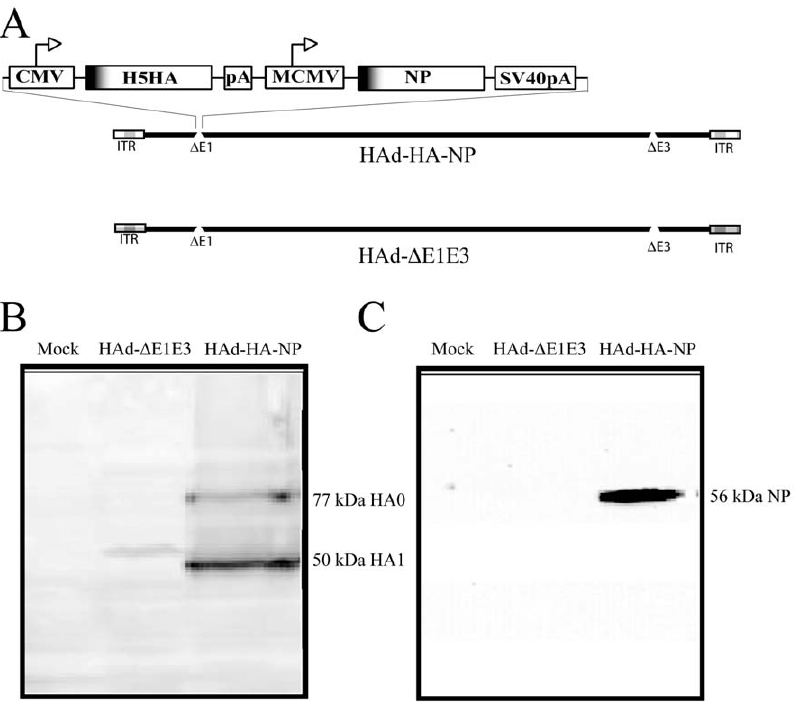
Figure 1. Replication-defective HAd vector (HAd-HA-NP) expresses HA and NP of a H5N1 influenza virus in vector-infected cells. (A) Diagrammatic representation of replication-deficient HAd vectors, HAd- D E1E3 [HAd5 with deleted E1 and E3 regions] and HAd-HA-NP [HAd- D E1E3 with hemaggluttinin (HA) and nucleoprotein (NP) gene from A/Vietnam/1203/04 (H5N1) influenza virus]. ITR, inverted terminal repeat; CMV, cytomegalovirus immediate early promoter; pA, polyadenylation signal; MCMV, mouse cytomegalovirus immediate early promoter; SV40pA, simian virus polyadenylation signal. (B and C) Expression of H5N1 HA and NP in 293 cells infected with HAd-HA-NP. Mock (PBS-infected), HAd- D E1E3-, or HAd-HA-NP-infected 293 cells were harvested 48 h post-infection, and cell lysates were analyzed by Western blot using polyclonal serum against H5 HA or a NP-specific mouse monoclonal antibody.